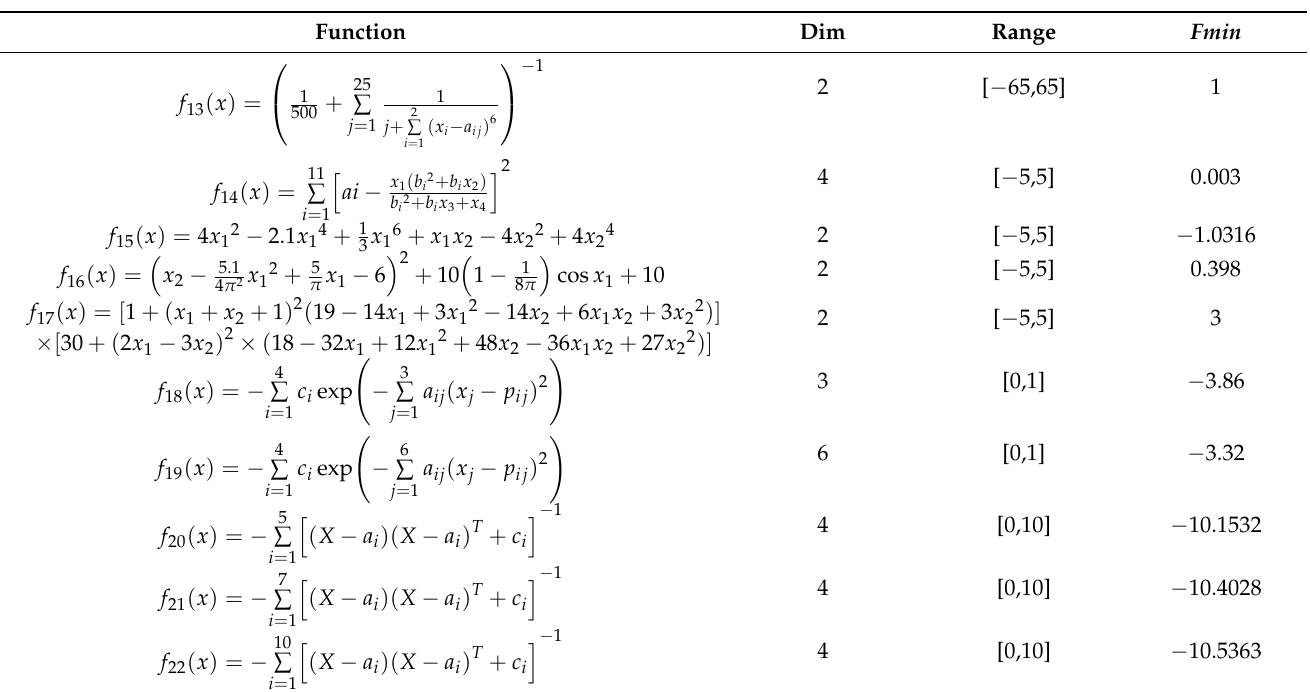
Table 4. Fixed-dimension test